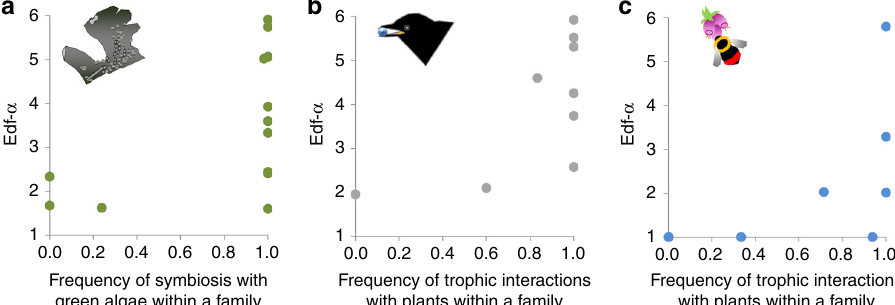
Fig. 3 The complexity of species richness-elevation relationships increases for certain types of interactions. a , b , c Scatterplots of the relationships between the parameters of the smoothing function Edf- α of confamilial communities, on the y -axis, and measures of the incidences of green algal endosymbiosis in lichens and of trophic interactions with plants in animals, on the x -axis. Each point represents a family. Source data are provided as a Source Data